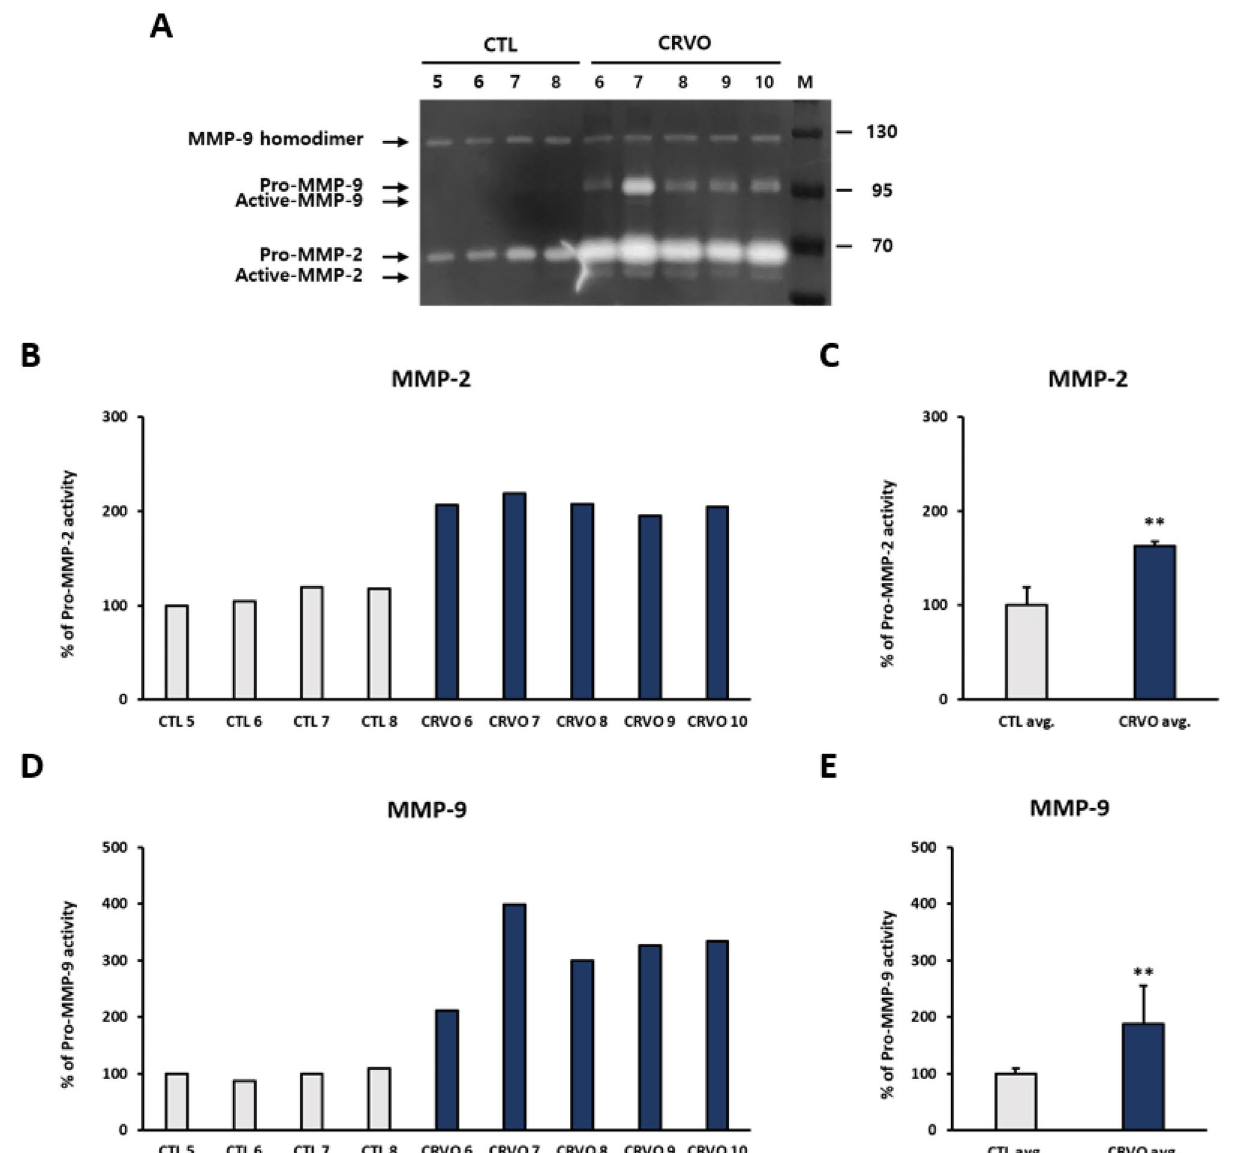
Figure 3. Gelatin zymography evaluating gelatinases activity in the aqueous humor of patients with CRVO and control subjects. ( A ) Acrylamide gel containing 0.1% gelatin was reacted with white bands by MMP-2 and -9 gelatinases. ( B , D ) % of pro-MMP-2 and MMP-9 activity are displayed in the graphs. ( C , E ) The averages of the control and CRVO groups were expressed as the % of pro-MMP-2 and -9 activity. Both results were increased in the CRVO group compared with the control